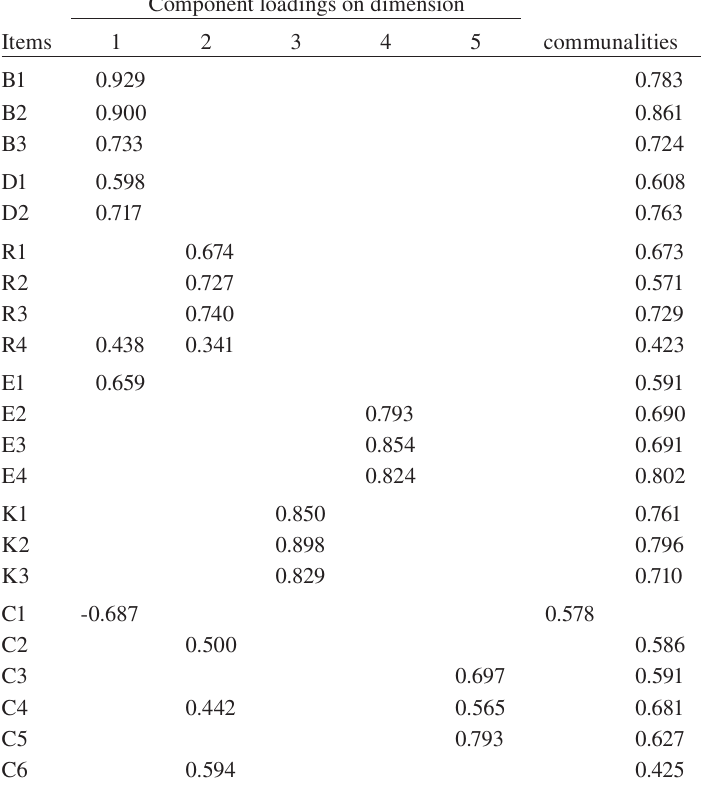
Component loadings on